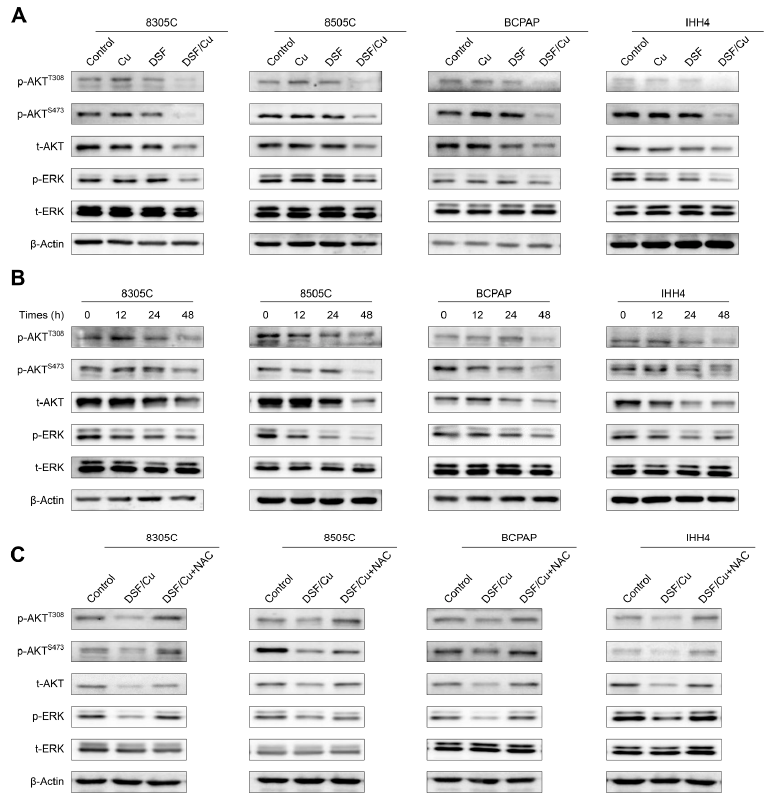
Figure 3. DSF/Cu inhibits the activities of MAPK/ERK and PI3K/AKT pathways via an ROS-dependent mechanism. ( A ) The indicated cells were treated with vehicle control, 0.5 µ M DSF and/or 0.5 µ M CuCl 2 for 48 h, and cell lysates were then subjected to Western blot analysis to determine their effects on the levels of phosphorylated ERK (p-ERK), total ERK (t-ERK), phosphorylated AKT at Ser 473 (p-AKT S473 ), phosphorylated AKT at Thr308 (p-AKT T308 ) and total AKT (t-AKT). β -Actin was used as a loading control. ( B ) Western blot analysis of p-ERK, t-ERK, p-AKT S473 , p-AKT T308 and t-AKT in indicated cells treated with vehicle control or 0.5 µ M DSF/Cu for 0, 12 h, 24 h and 48 h, with β -Actin as a loading control. ( C ) Western blot analysis of p-ERK, t-ERK, p-AKT S473 , p-AKT T308 and t-AKT in indicated cells treated with 0.5 µ M DSF/Cu or in combination with 2 mM NAC. β -Actin was also used as a loading control.